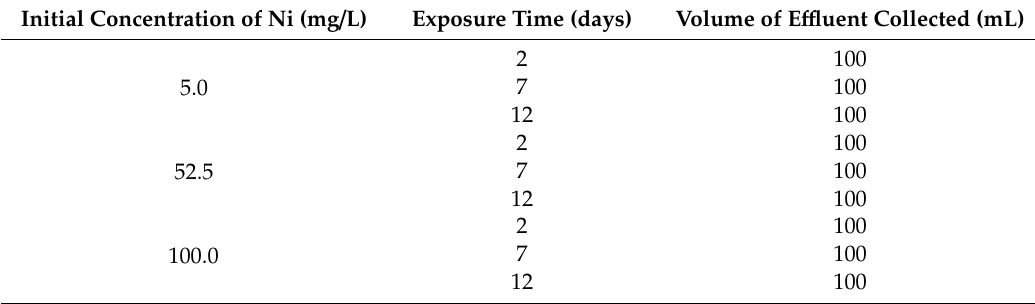
Table 1. Value of initial Ni concentration and exposure